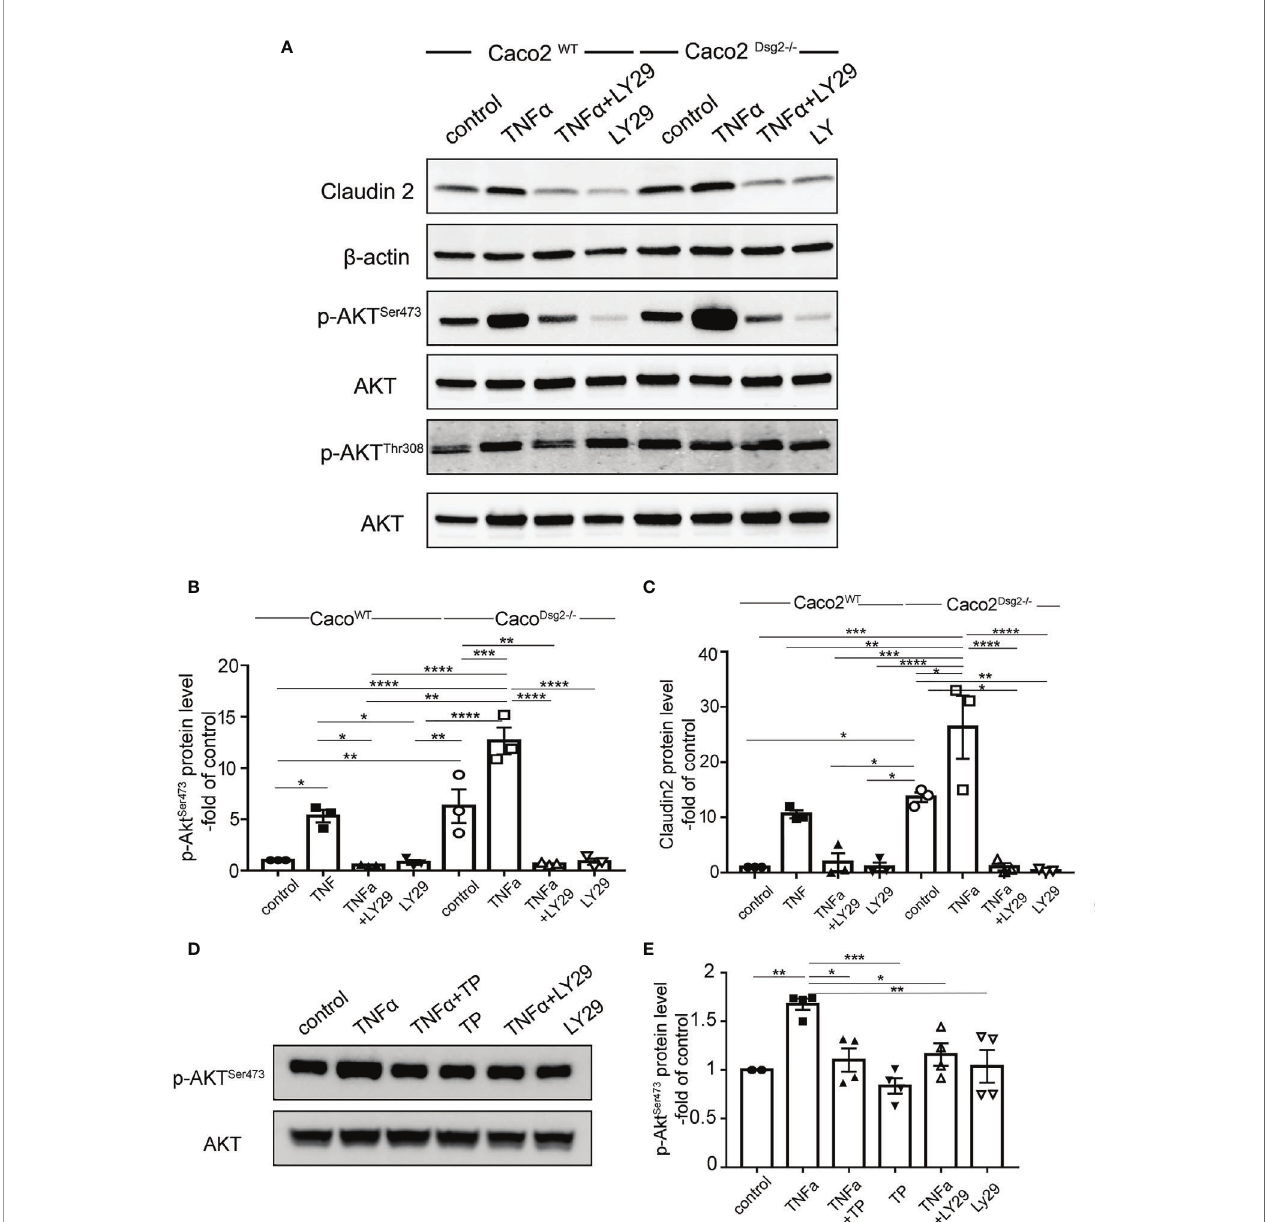
FIGURE 6 | PI-3K/Akt pathway is involved in the regulation of Claudin2. (A) Western Blot of Caco2 WT and Caco2 Dsg -/- are shown for Claudin2, p-AKT Ser473, p- AKT Thr308 , total AKT and ß-actin as loading control under the different experimental conditions. Experiment shown is representative for n=3. (B) Quantitative analyses of the optical densities for p-AKTSer473/total AKT; ordinary 1-way ANOVA are presented. (C) Quantitative analyses of the optical densities for Claudin2 Western Blot bands normalized to b -actin are shown; ordinary 1-way ANOVA. (D) Western Blot of Caco2 WT for p-AKT Ser473 and total AKT for the different experimental conditions are shown. Experiment shown is representative for n=4. (E) Quantitative analyses of the optical densities for p-AKT Ser473 /total AKT; ordinary 1-way ANOVA. Asterisks mark signi fi cant difference *p < 0.01, **p < 0.001, ***p < 0.0001, ****p < 0.00001). Comparisons are indicated by the lines above the